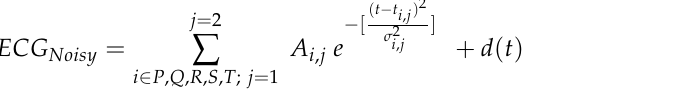
(8) Plot: The plot button is for showing the generated ECGs. (9) Save Result: Save result is also a button for saving the generated ECG in mat for- (10) FFT & PSD: This checkbox enables and disables the FFT and Power spectral den- sity (PSD). By seeing these two, the user can understand the frequency domain property of the model generated ECG. (11) BPM: This text box can do beat per minute or BPM of the generated ECG by default; the system always generates 72 BPM ECG signal. As bradycardia and tachycardia are nothing but less or high BPM by changing the beat rate, it is possible to create brady- cardia and tachycardia like Figure 12.